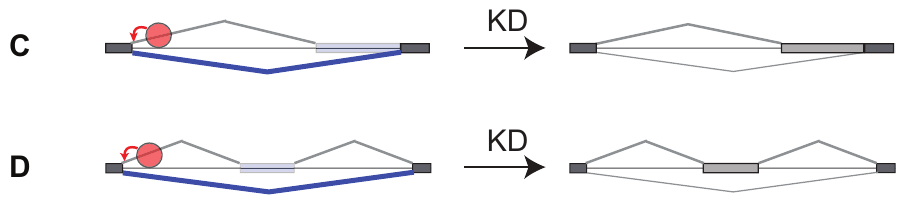
Figure 7. An overview of the models of TIA-dependent splicing regulation. (A) TIA proteins can directly regulate 5 9 splice site competition by enhancing either intron-proximal or intron-distal 5 9 splice sites. (B) TIA proteins directly regulate alternative cassette exon inclusion by enhancing 5 9 splice sites. (C) TIA proteins promote the use of intron-distal alternative 3 9 splice sites without directly modulating competition between the alternative 3 9 splice sites. By enhancing 5 9 splice site recognition, TIA proteins decrease the inclusion of the variable portion of the exon. The splicing kinetics model proposes that the splicing kinetics is affected by 5 9 splice site recognition, which then indirectly affects the ability of SR proteins and other factors to define the variable portion of the distal exon. According to this model, the slower splicing kinetics in the absence of TIA increases the time available to these factors to promote inclusion of the variable portion of the exon. (D) Similar to the effect on distal variable exons, a change in splicing kinetics could contribute to the ability of TIA proteins to promote skipping of distal alternative cassette exon by binding at the upstream 5 9 splice site.